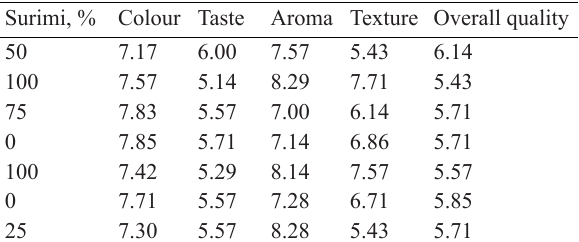
Table 5 Average scores of sensory characteristics of burger samples for selecting proper concentrations of cumin and thyme